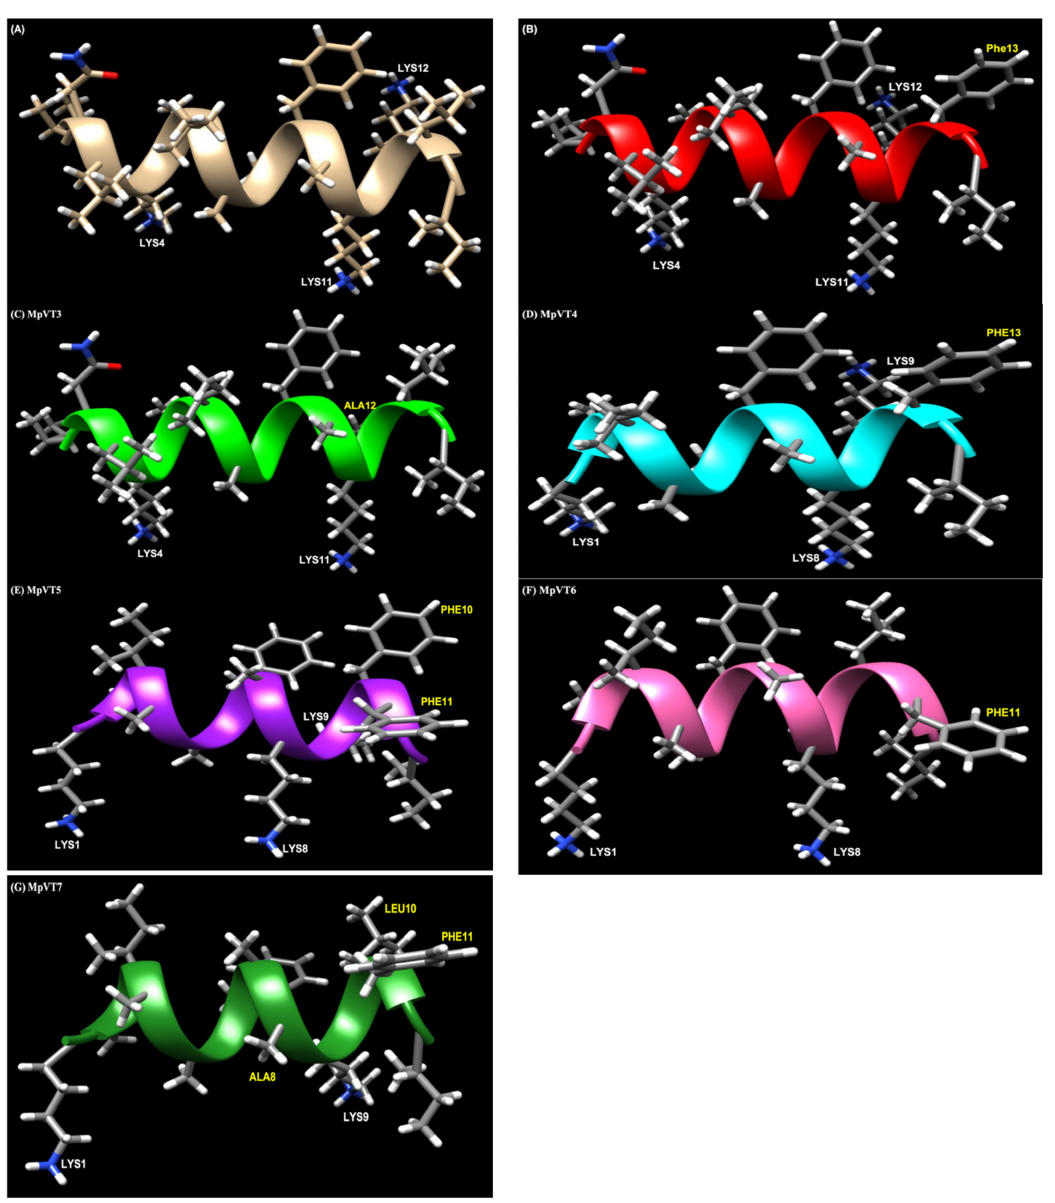
Figure 4. Structural models of MpVT and its analogs: ( A ) MpVT; ( B ) MpVT1; ( C ) MpVT3; ( D ) MpVT4; ( E ) MpVT5; ( F ) MpVT6; and ( G ) MpVT7. The models present the secondary structure in ribbon structure and the amino acid in sticky residues. Cationic residues (Lys amino acid) are labeled in white letters and the amino acid substitution is labeled in yellow